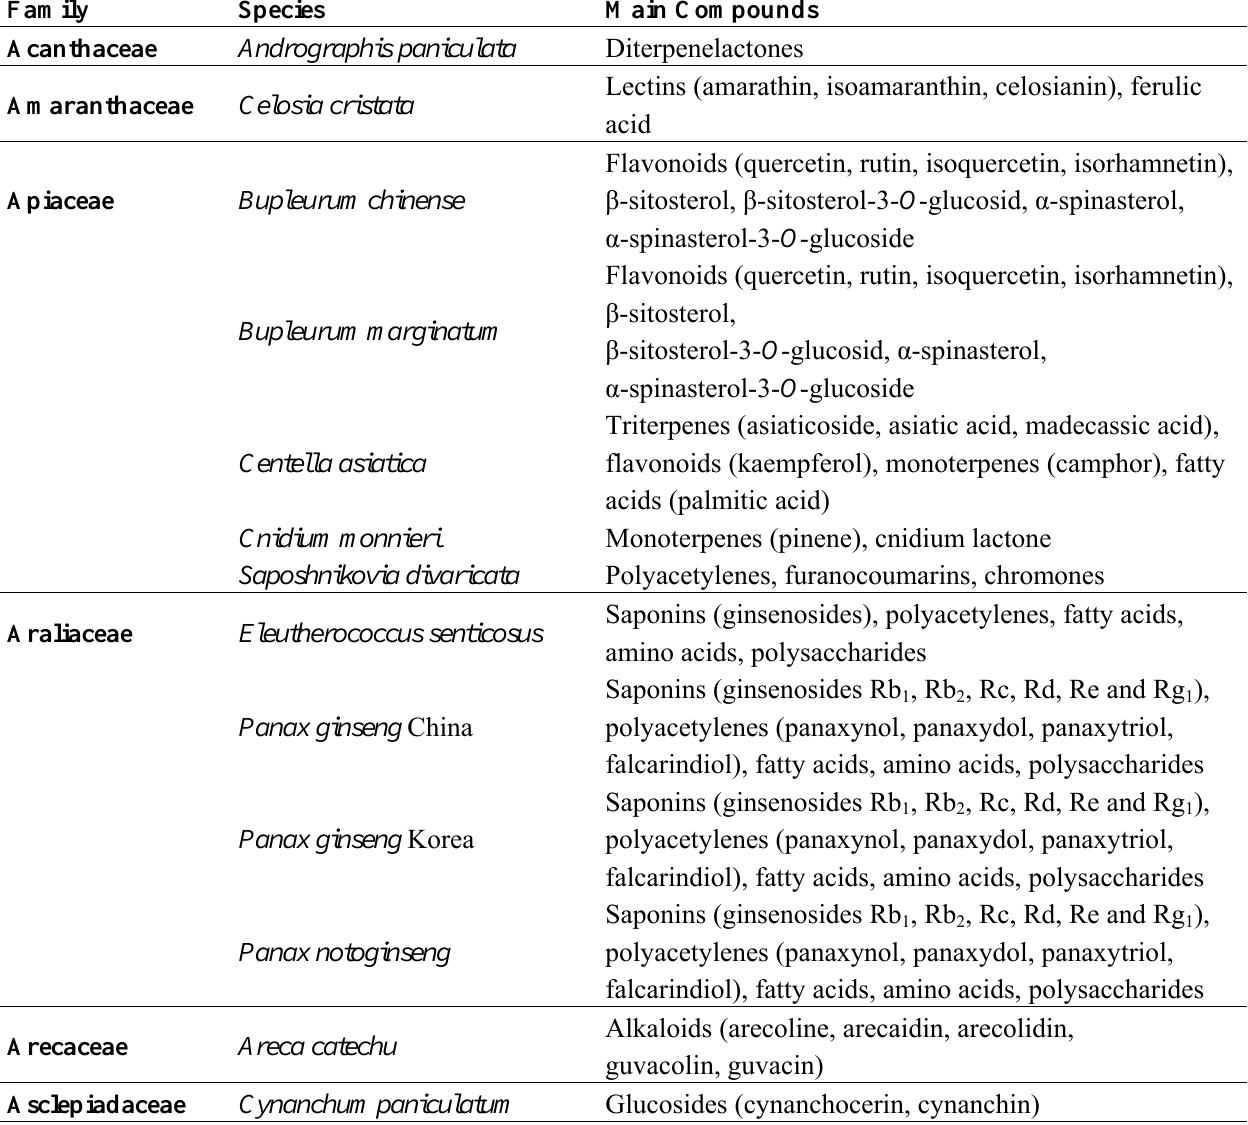
Table 2. Main Compounds of Plants used in this study